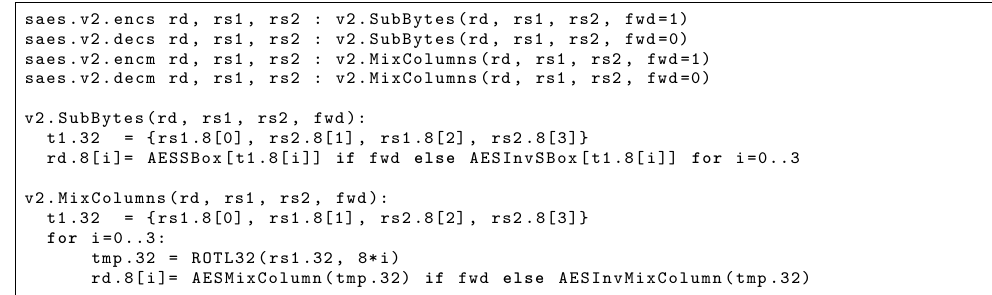
Figure 3: Instruction mnemonics, and their mapping onto pseudo-code functions, for V 2 .